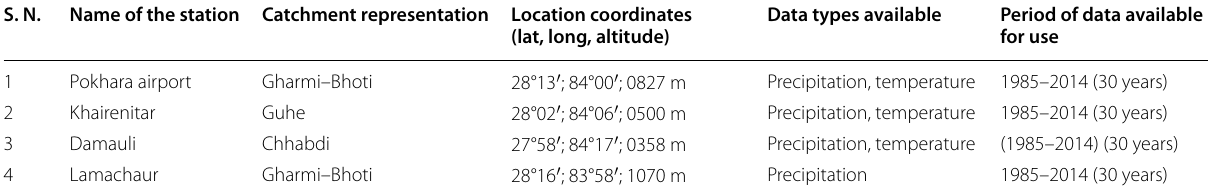
Table 1 Details of meteorological stations for climatic data S. N.